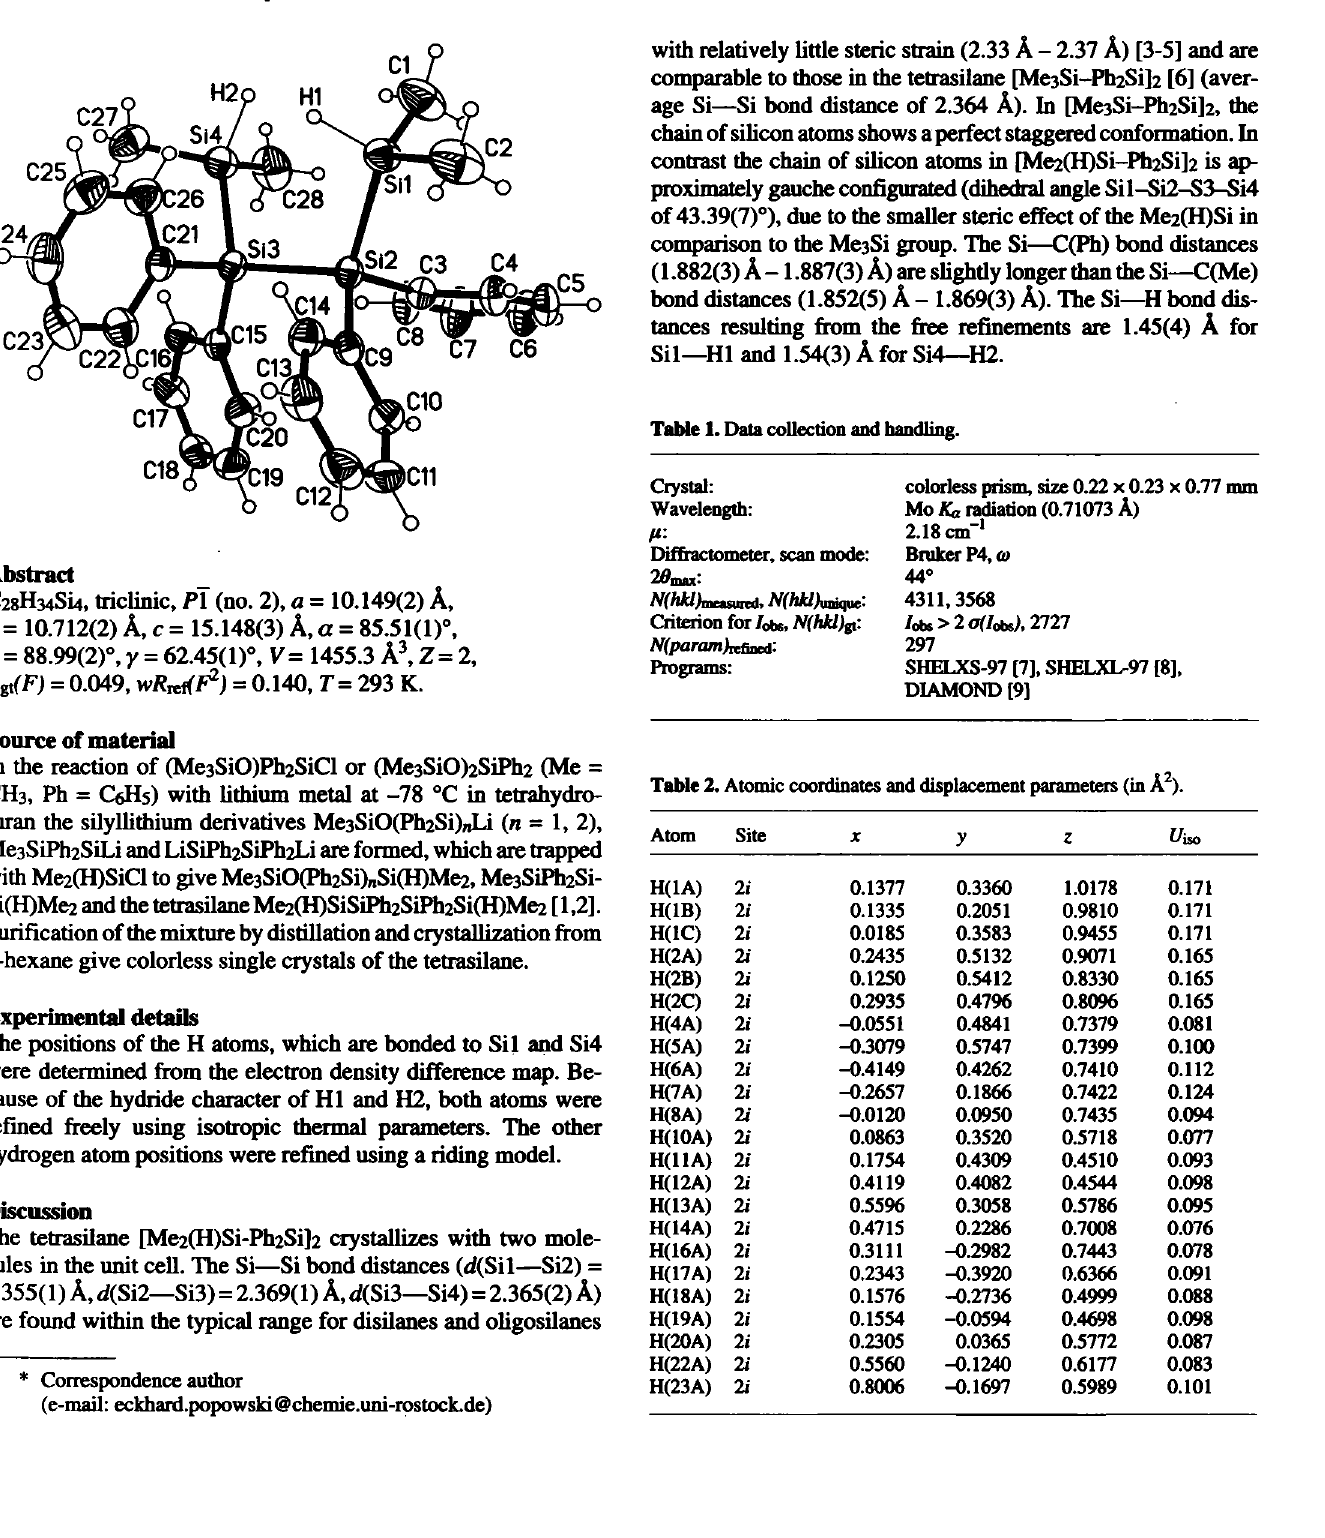
Table 1. Data collection and handling.